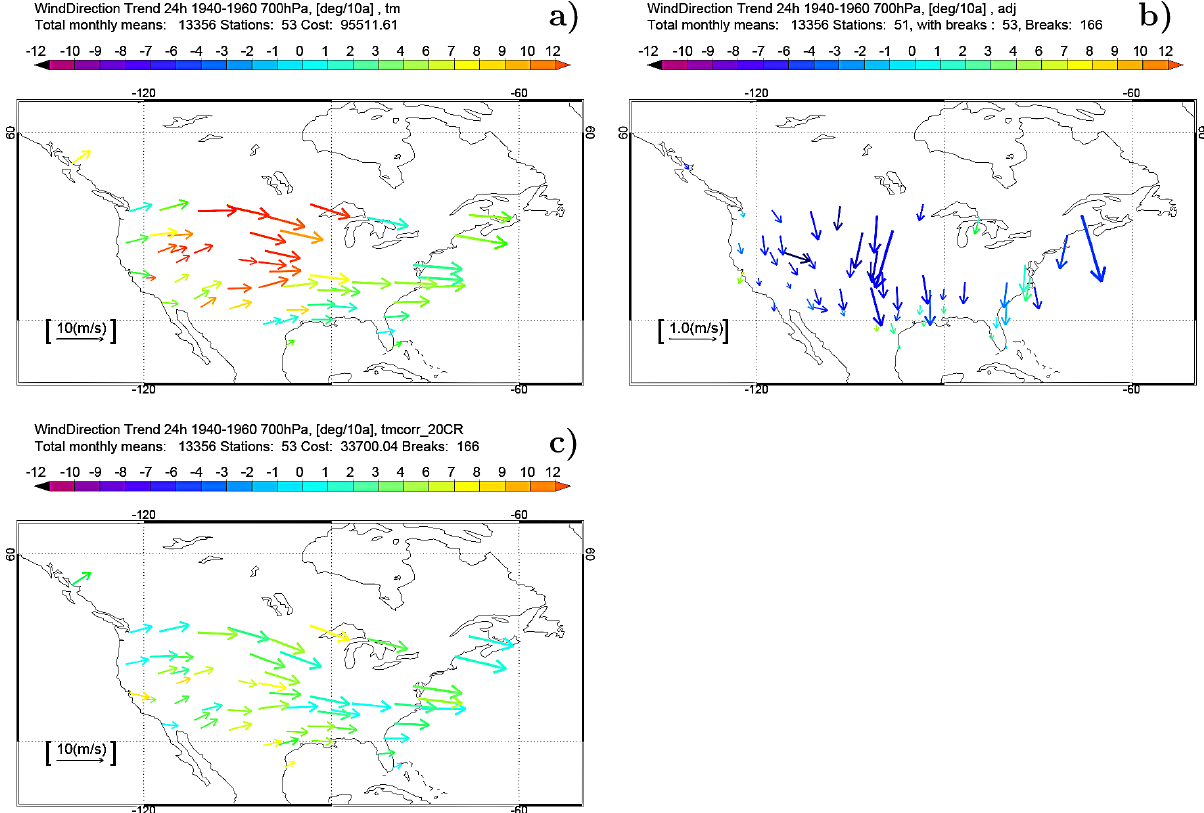
Figure 10. (a) Raw wind direction trends at 700hPa at US stations (WMO numbers between 71000 and 73000) for the period 1940–1960 averaged over both 00:00 and 12:00UTC (most stations reported twice daily). Arrows depict the mean wind speed and direction over this period. Arrow color indicates wind direction trend over the investigated period. Only stations with less than 1 year of missing values are shown. (b) Wind direction adjustments (1U,1V ) as estimated by RAOBCORE 2.0. The arrows show size and direction of the adjustments; the colors show how much the wind direction trend has been changed due to the adjustments. Note scale difference in arrow length compared to (a) . 174 shifts have been adjusted in total. (c) shows wind direction trends after adjustment. The cost function measuring spatial-trend heterogeneity (see Haimberger, 2007; Haimberger et al., 2012) has been reduced by a factor of 3 compared to (a)